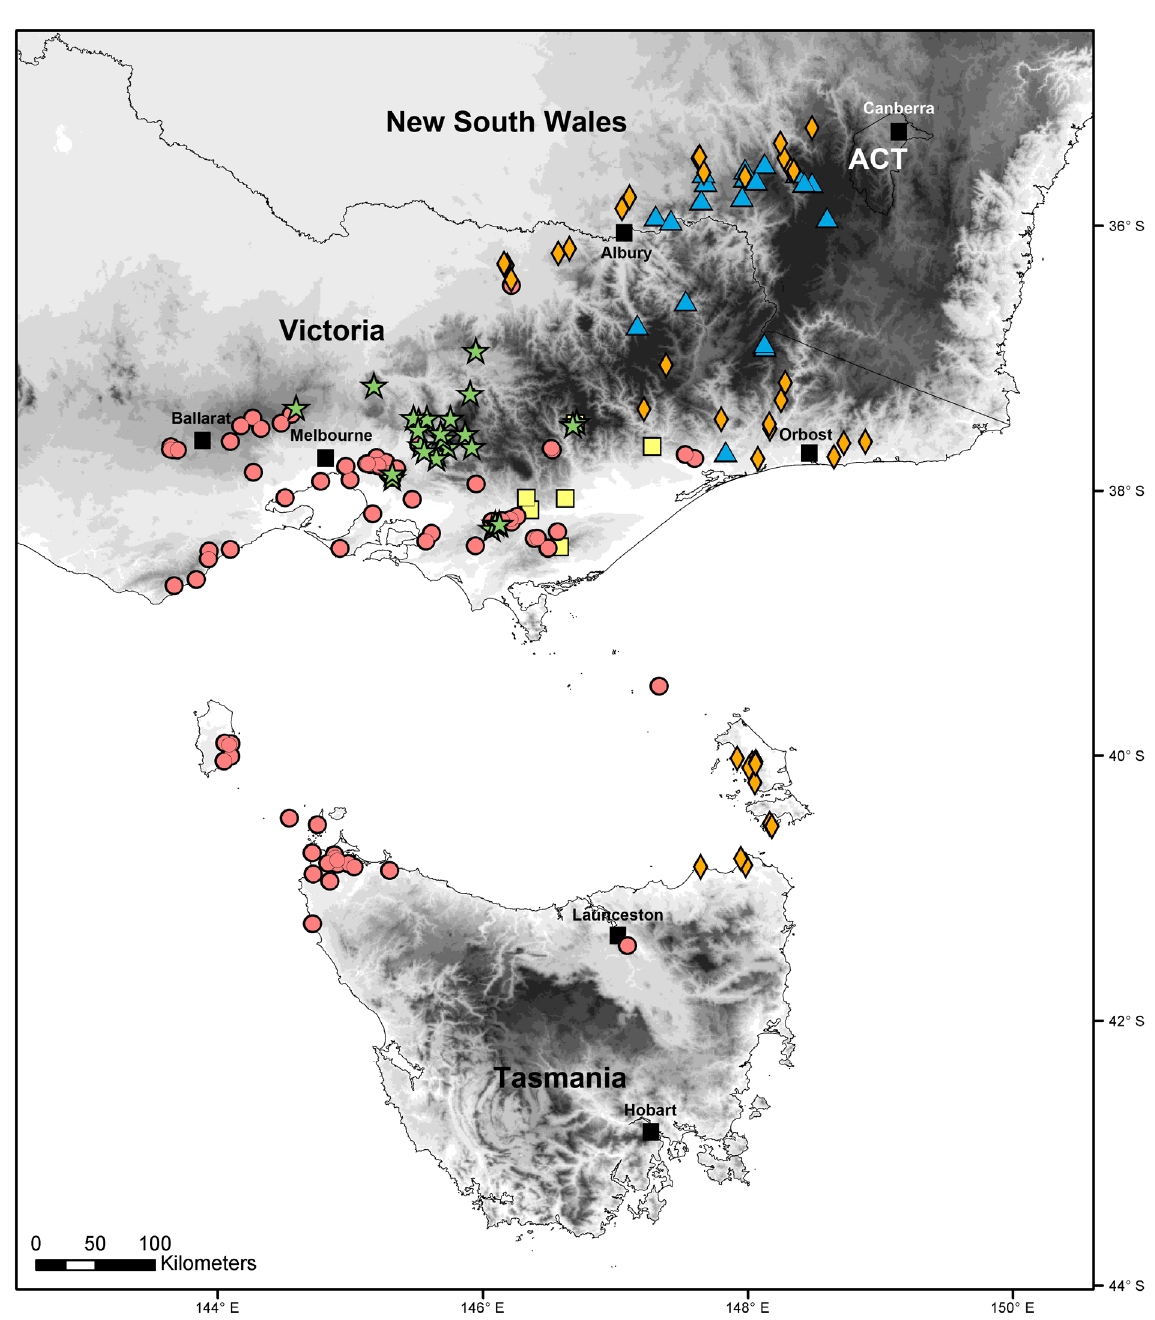
Fig. 7. Map of southeastern Australia and Tasmania, showing the known distribution of Pogonosternum spp.: red circles = P. nigrovirgatum (Carl, 1902); green stars = P. laetificum Jeeker, 1982; yellow squares = P. adrianae Jeeker, 1982; blue triangles = P. montanum Decker, sp. nov.; orange diamonds = P. jeekeli Decker, sp. nov. Abbreviation: ACT = Australian Capital